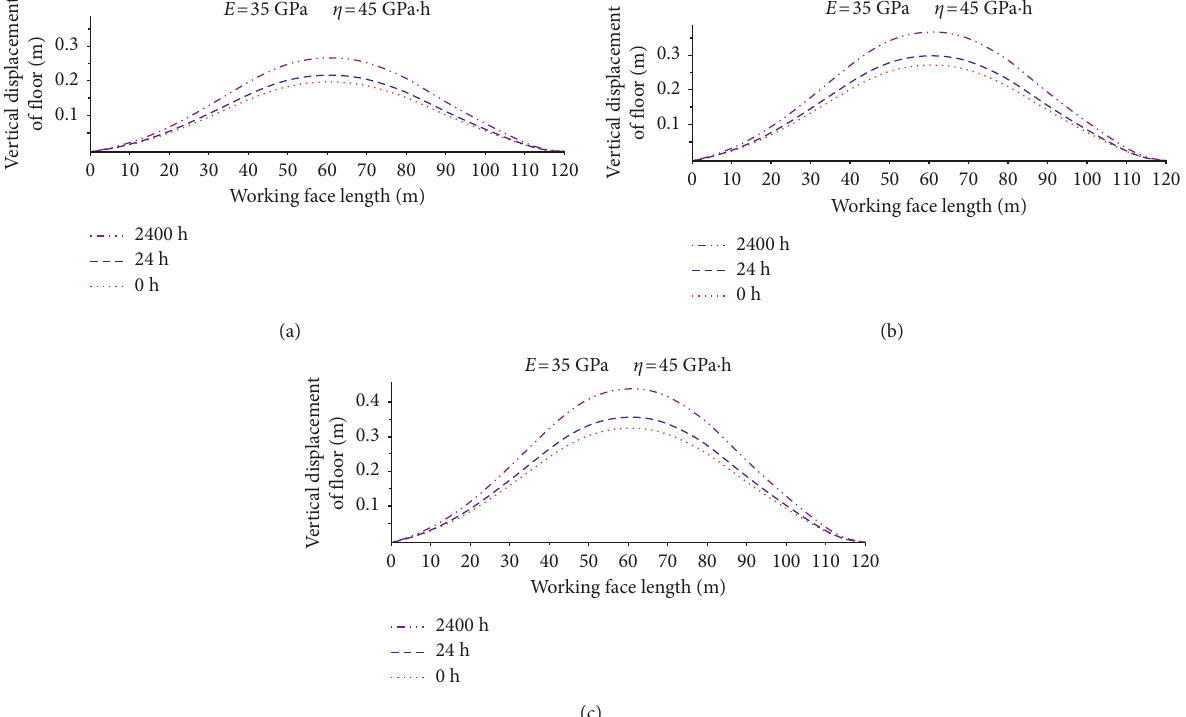
1 . 5 MPa. (b) p 2 . 5 MPa. (c) p 4 . 5 (cid:29) (cid:29) (cid:29)